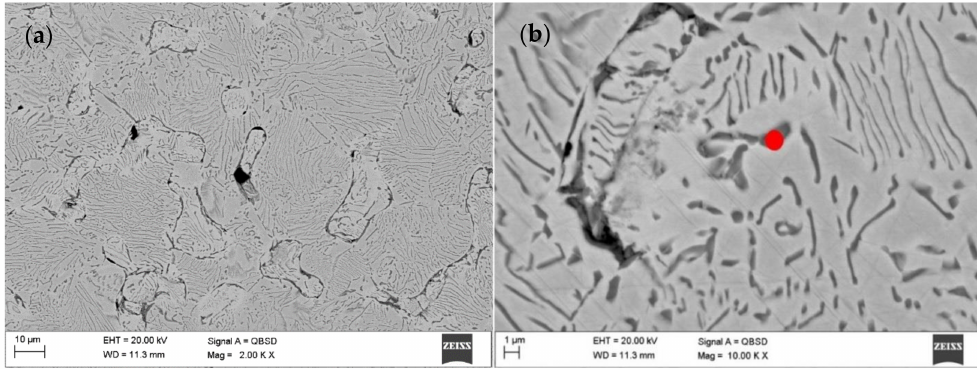
Figure 7. ( a ) SEM image of the central part of sample after debinding under N 2 and sintering at 1350 ◦ C under N 2 -5%H 2 ; ( b ) SEM image of the central part of sample after debinding under N 2 and sintering at 1350 ◦ C under N 2 -5%H 2